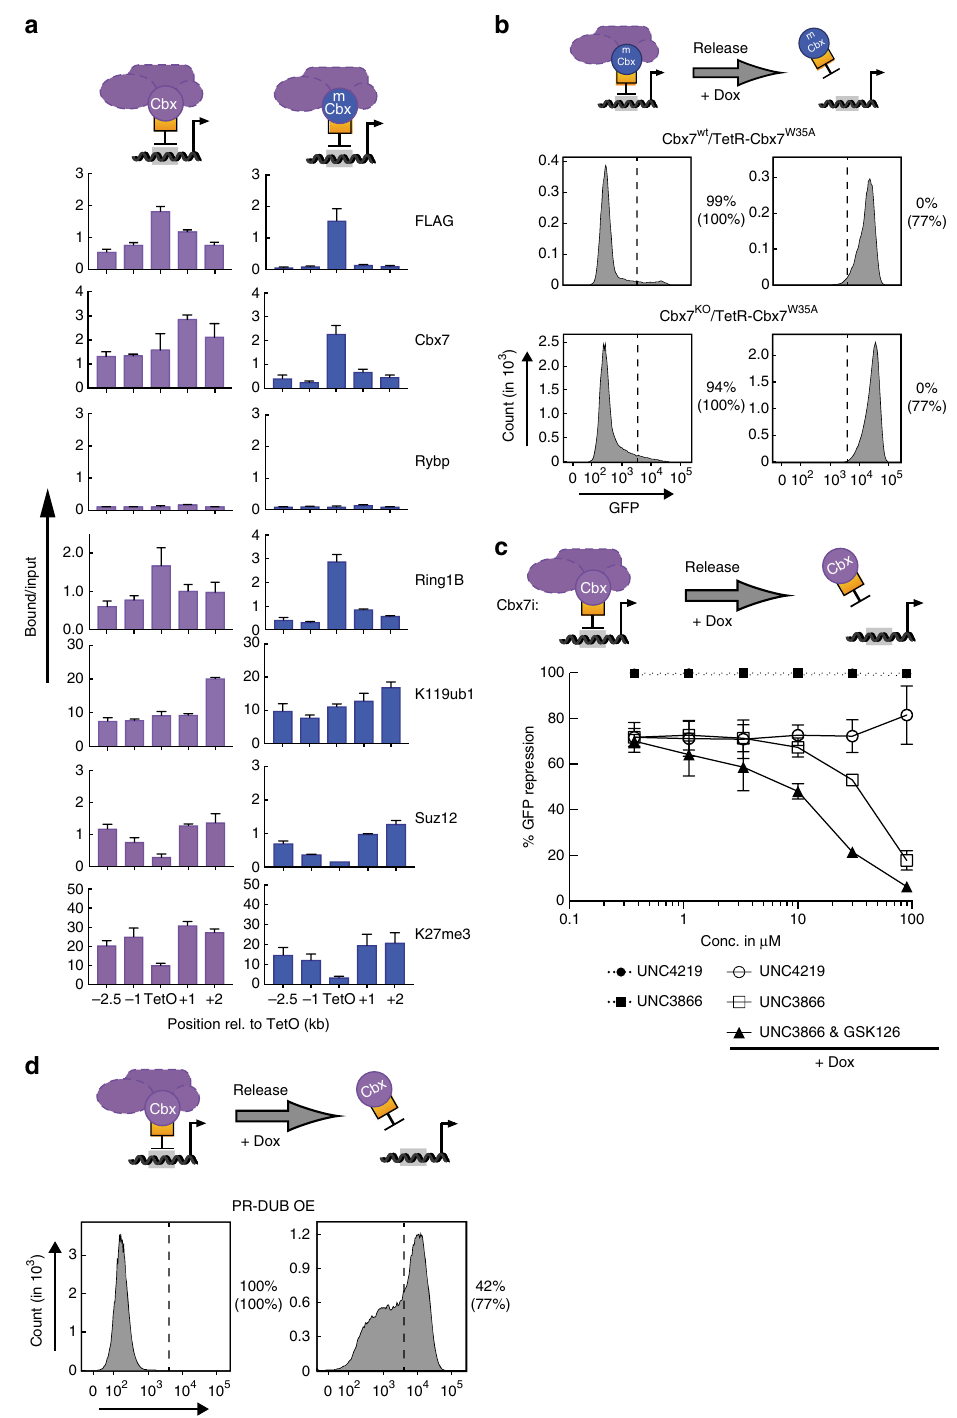
Fig. 4 Interaction of Cbx7 with H3K27me3 is essential for cPRC1-dependent inheritance. a ChIP qPCR analyses compares relative enrichments of PcG proteins and histone modi fi cations in reporter cells expressing wild-type and mutant FLAG-TetR-Cbx7. ChIP enrichments for H2AK119ub1 and H3K27me3 are normalized to negative control locus (IAP). Data are mean ± SD (error bars) of at least two independent experiments. Source data are provided as a Source Data fi le. b Flow cytometry histograms compare GFP expression before and after three days of Dox treatment of wild-type (gray — upper panels) and Cbx7 KO dual reporter cells expressing TetR-Cbx7 W35A (gray — lower panels). Percentages indicate fraction of silenced reporter cells expressing either mutant or wild-type TetR fusion (in brackets). c Percentage of GFP-negative cells before and after 6 days of Dox treatment in response to increasing concentrations of Cbx7 inhibitor (UNC3866) alone, in combination with 4 μ M GSK126 or control compound (UNC4219). Data are mean ± SD (error bars) of two independent experiments. d GFP histograms before and after 6 days of Dox addition to TetR-Cbx7 reporter cells with overexpression of Bap1 and Asxl1 (PR-DUB OE), components of the human PR-DUB complex speci fi c for H2AK119ub1. Percentages indicate fraction of silenced cells in PR-DUB OE and wild-type reporter cell lines (in